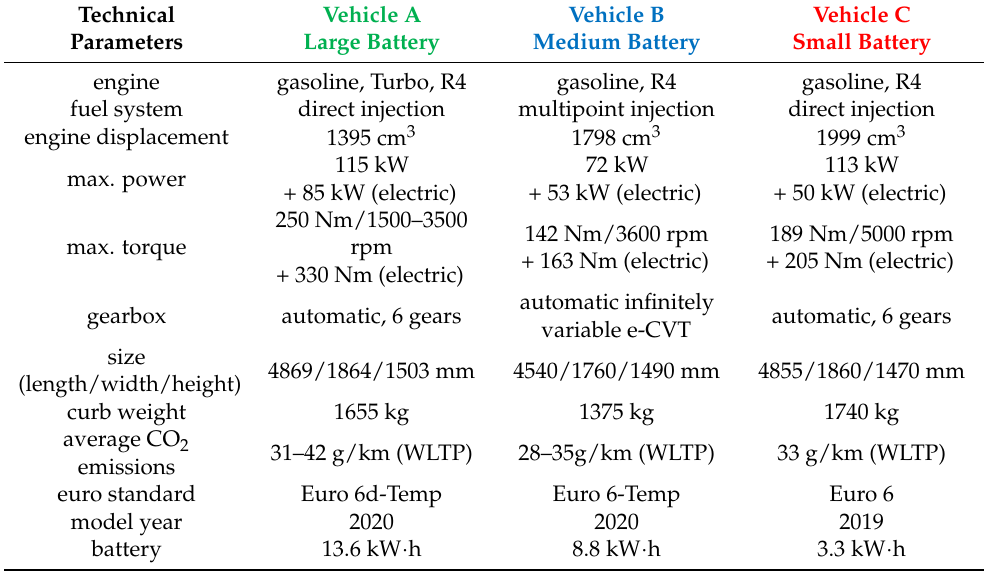
Table 5. Technical parameters of plug-in